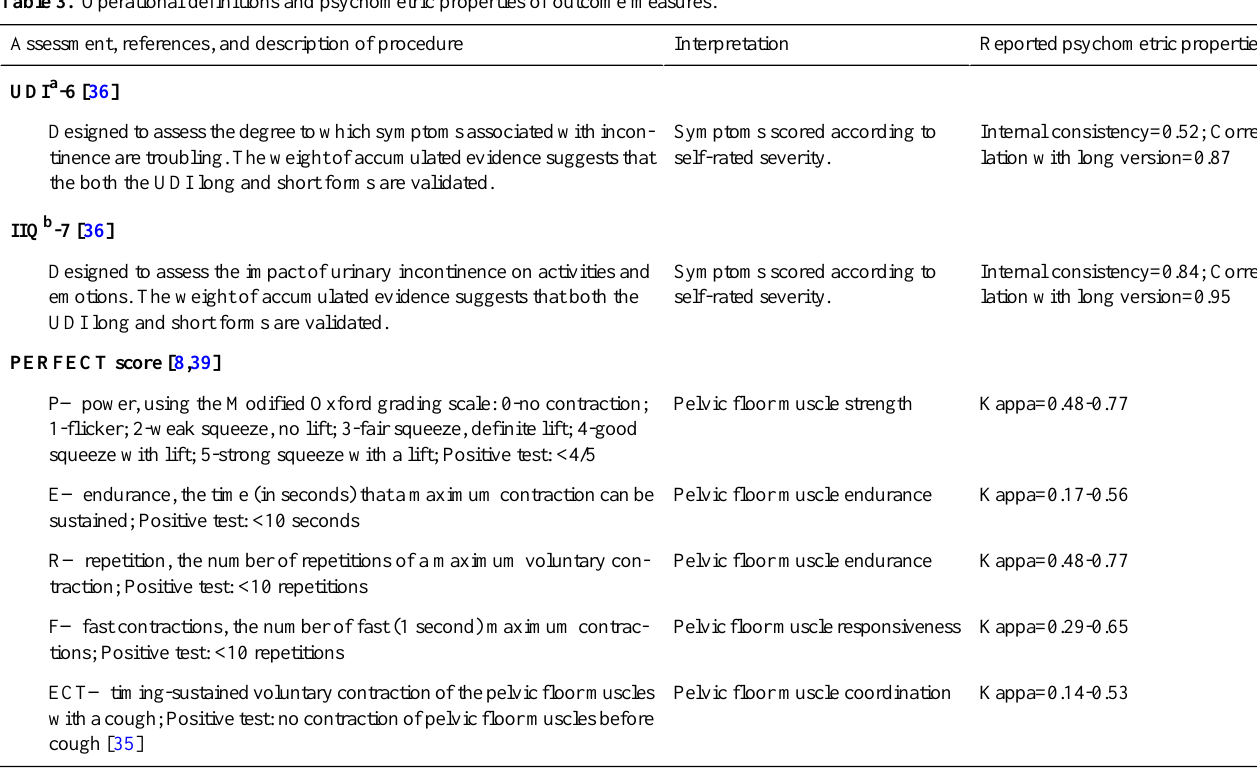
Table 3. Operational definitions and psychometric properties of outcome measures.